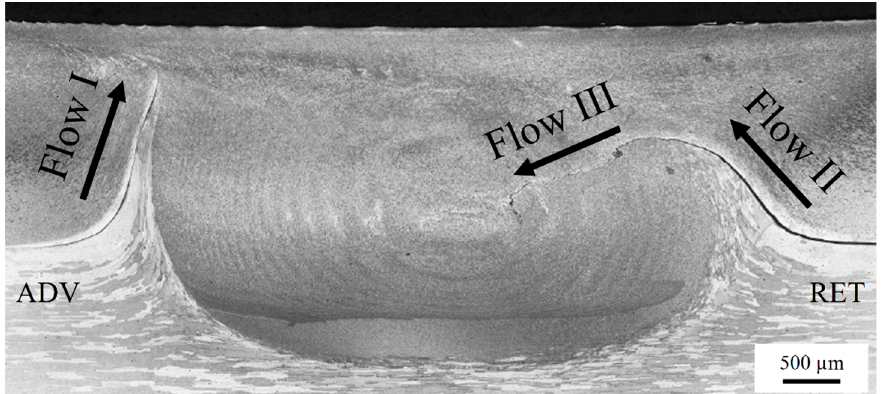
Figure 4. Material flow produced by the conventional threaded tool operated at 1200 rpm and 150 mm/min. Tool translation movement was forward from the shown cross-section.